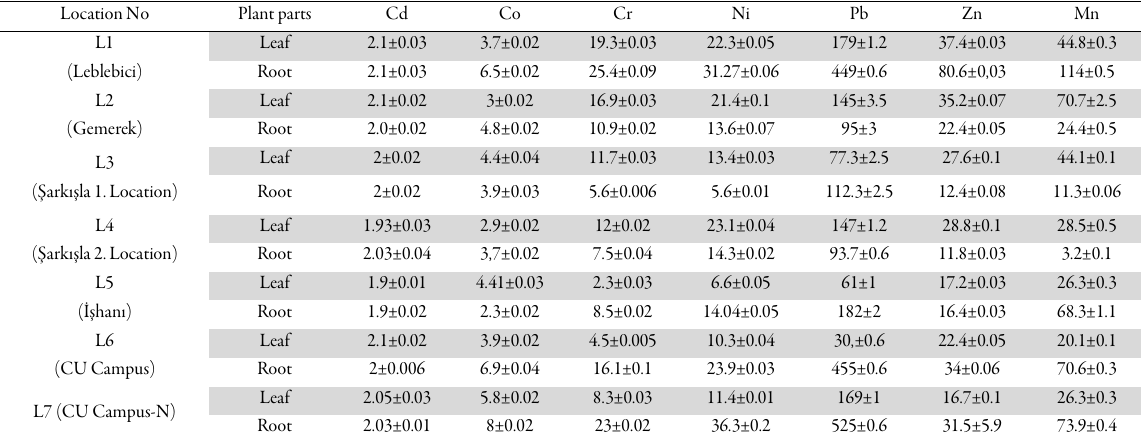
Table 5. Heavy metal ratios in the leaves and roots of Echium italicum plant (ppm) Location No Plant parts Cd L1